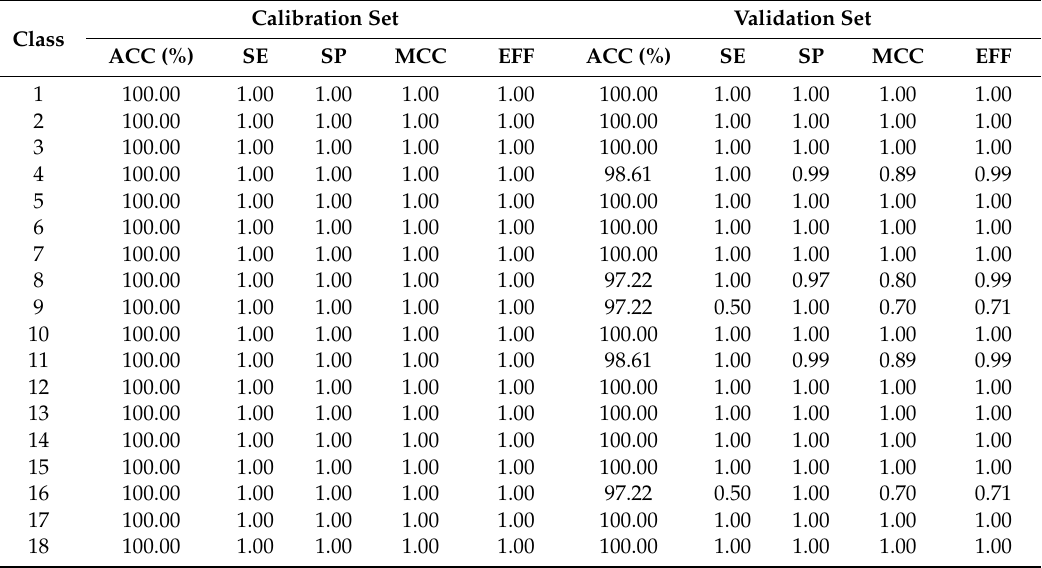
Table 6. The major parameters of KNN model based on FT-MIR full spectra